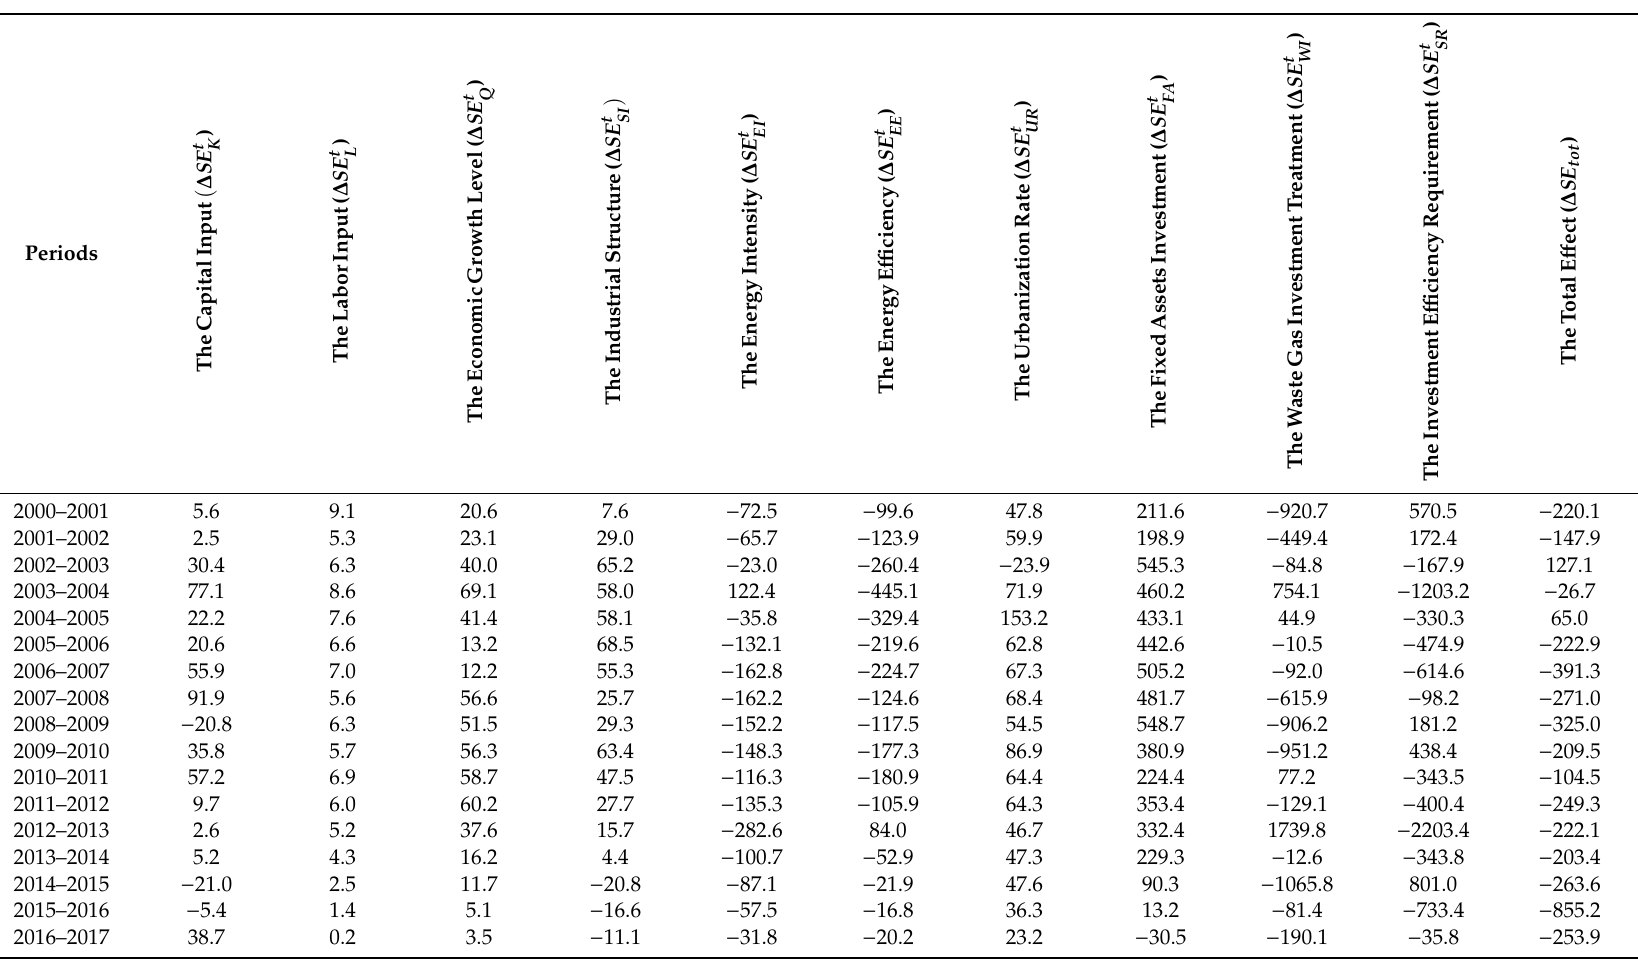
Table 7. The annual contribution of driving factors to SO 2